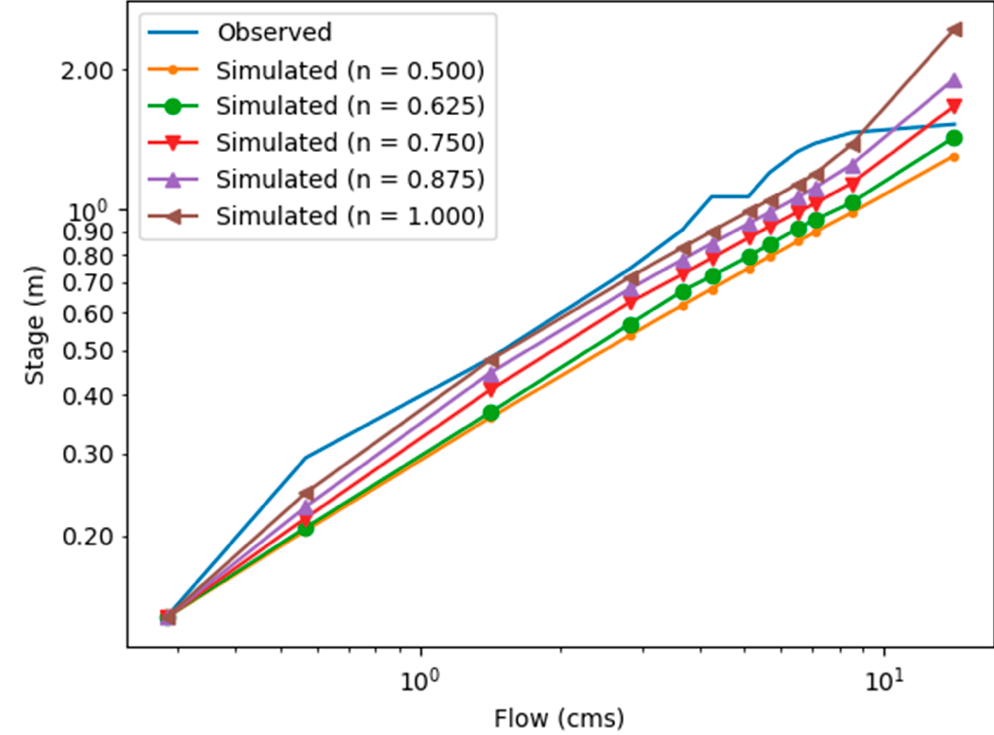
Figure 6. Raspy-Cal output that compares simulated with observed rating curves for demo project cross-section 900.00*. Note log scale due to large range in flow regime in some systems.